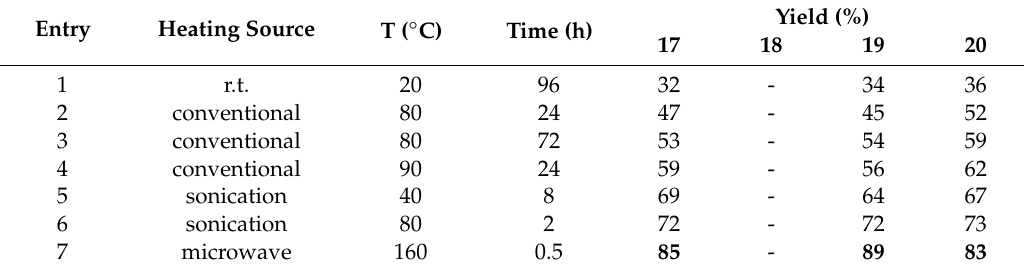
Table 4. Optimization of reaction conditions for the synthesis of compounds 17 – 20 .